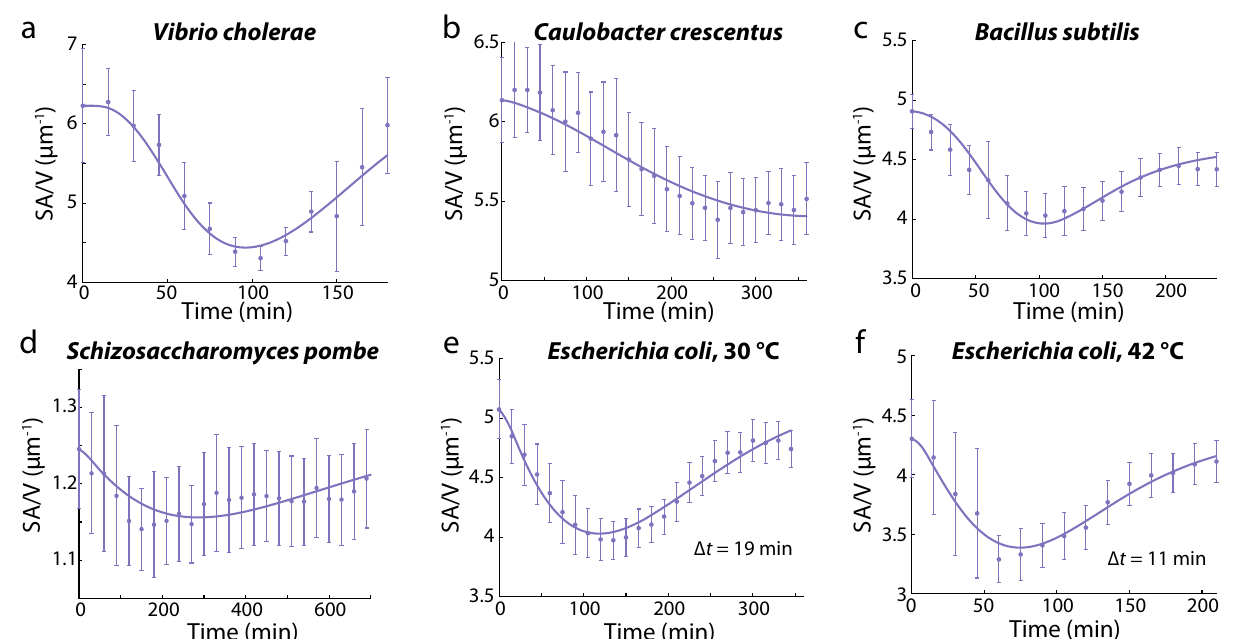
Fig. 5 SA/V dynamics are conserved across species and growth temperatures. Shape growth curves for multiple species and temperatures. V. cholerae ( a ) and C. crescentus ( b ) are Gram-negative, B. subtilis ( c ) is Gram-positive, and S. pombe ( fi ssion yeast) is a eukaryotic fungi ( d ). In all cases, cells exhibited similar trends with SA/V decreasing when cells resumed growth, and then gradually recovering when cell growth slowed down again. Data points are mean ± S.D., with n > 40 for d , and n > 200 for all other panels. Solid lines are fi ts to the time-delay model. The time delay at 30 °C ( e ) was ~70% longer than that at 42 °C ( f ), consistent with the difference in steady-state growth rates. Source data are provided as a Source Data fi